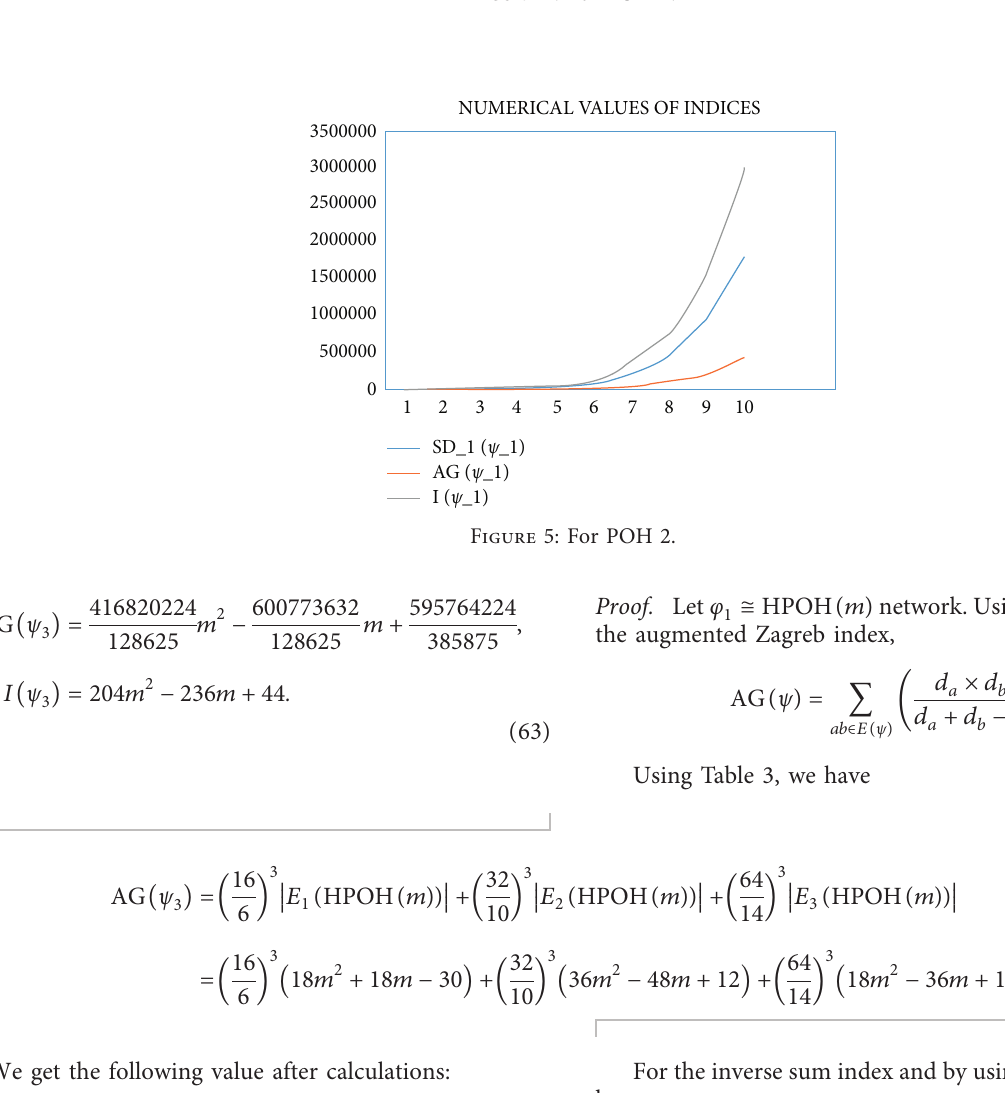
Figure 4: For POH 1.